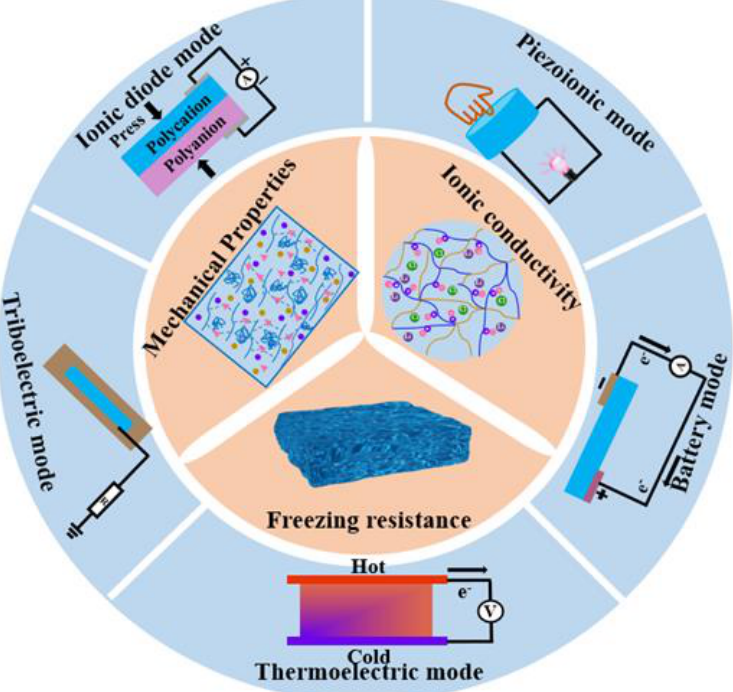
Figure 2. Schematic of the unique properties and modes of the ionic hydrogel self-powered tactile sensors.